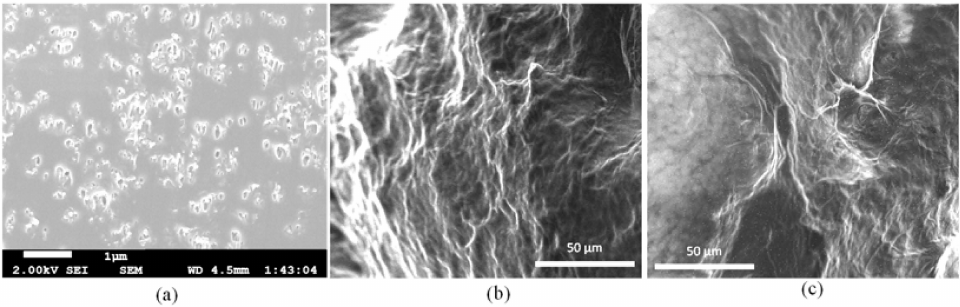
Figure 16. ( a ) SEM image of the pure TO-NFC film of 100 µ m. It represents the uniform distribution of TO-NFC fiber. SEM imaging performed on the cross-section of filaments fabricated with ( b ) A 2 C 2 T 1 and ( c ) A 2 C 2 T 0.5